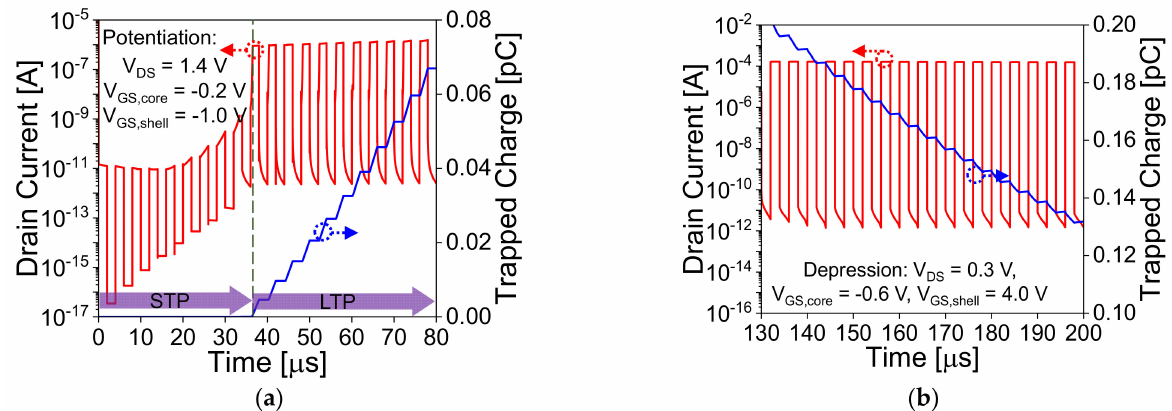
Figure 6. Transient analysis and trapped charges in the nitride layer during ( a ) potentiation and ( b ) depression. A sharp transition in current and trapped charges in the transient analysis of potentiation shows the transformation from short-term potentiation (STP) to long-term potentiation (LTP).